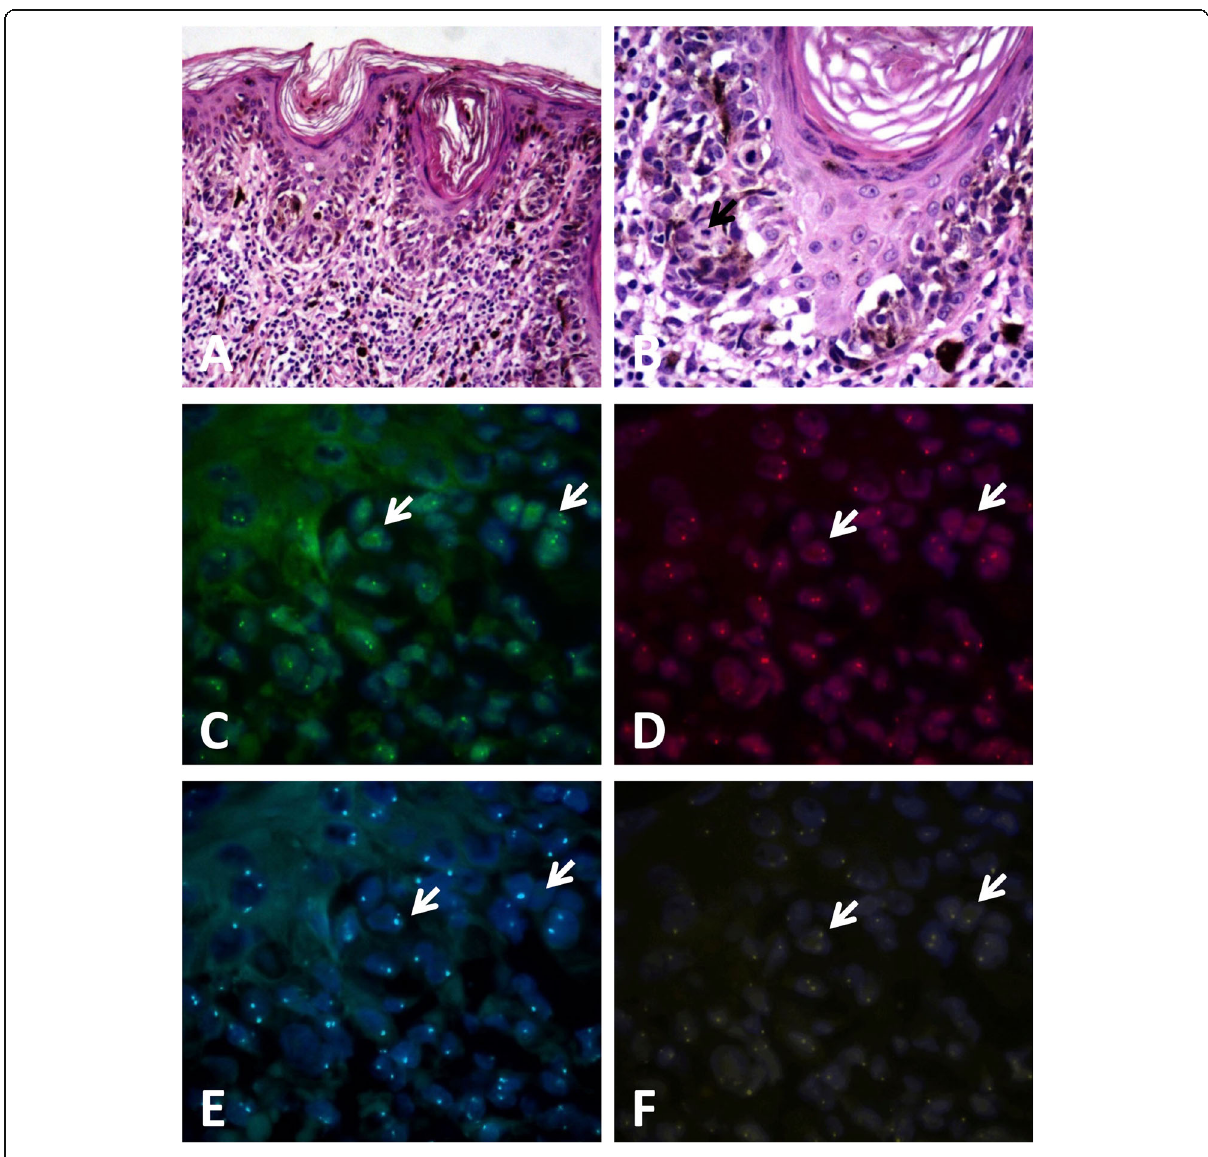
Fig. 3 Case of melanoma in situ negative by fluorescence in-situ hybridization (FISH) detection. a Melanocytes proliferated successively or in nests in the basal layer of the epidermis (hematoxylin and eosin, H&E staining),( b ) high-power magnification showed moderate atypia of the melanocytes with mitotic figures, which were easy to identify (black arrow)(H&E staining), ( c-f ) FISH images showed normal copies of CCND1 ( c , green signals), RREB1 ( d , red signals), CEP6 ( e , aqua signals), and MYB ( f , gold signals) in tumor cells (white